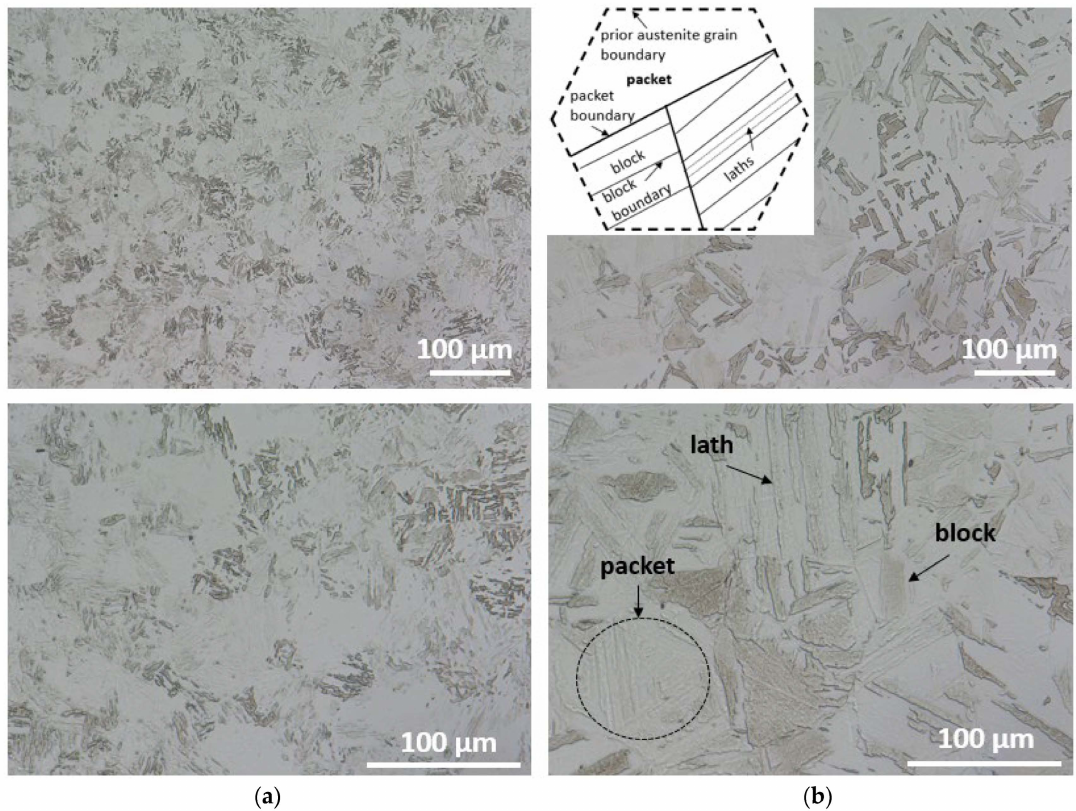
Figure 6. Image of Maraging 350 steel in ( a ) as-delivered state, ( b ) after DSC testing made by using a digital microscope (together with a schematic representation of lath martensite structures, e.g., laths, blocks, packets, within a prior austenite